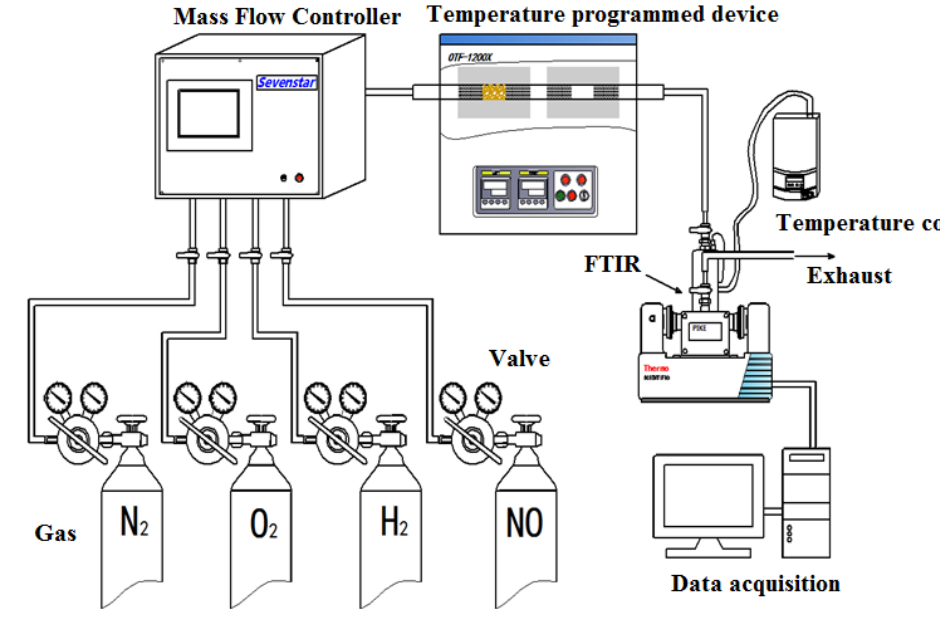
Figure 1: Schematic of experimental system.